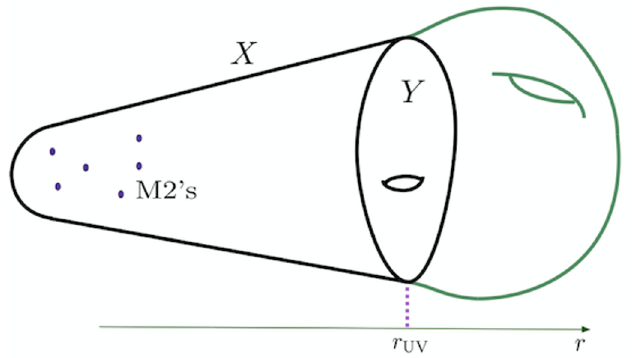
Figure 3 . The holographic theory as local geometry of a warped